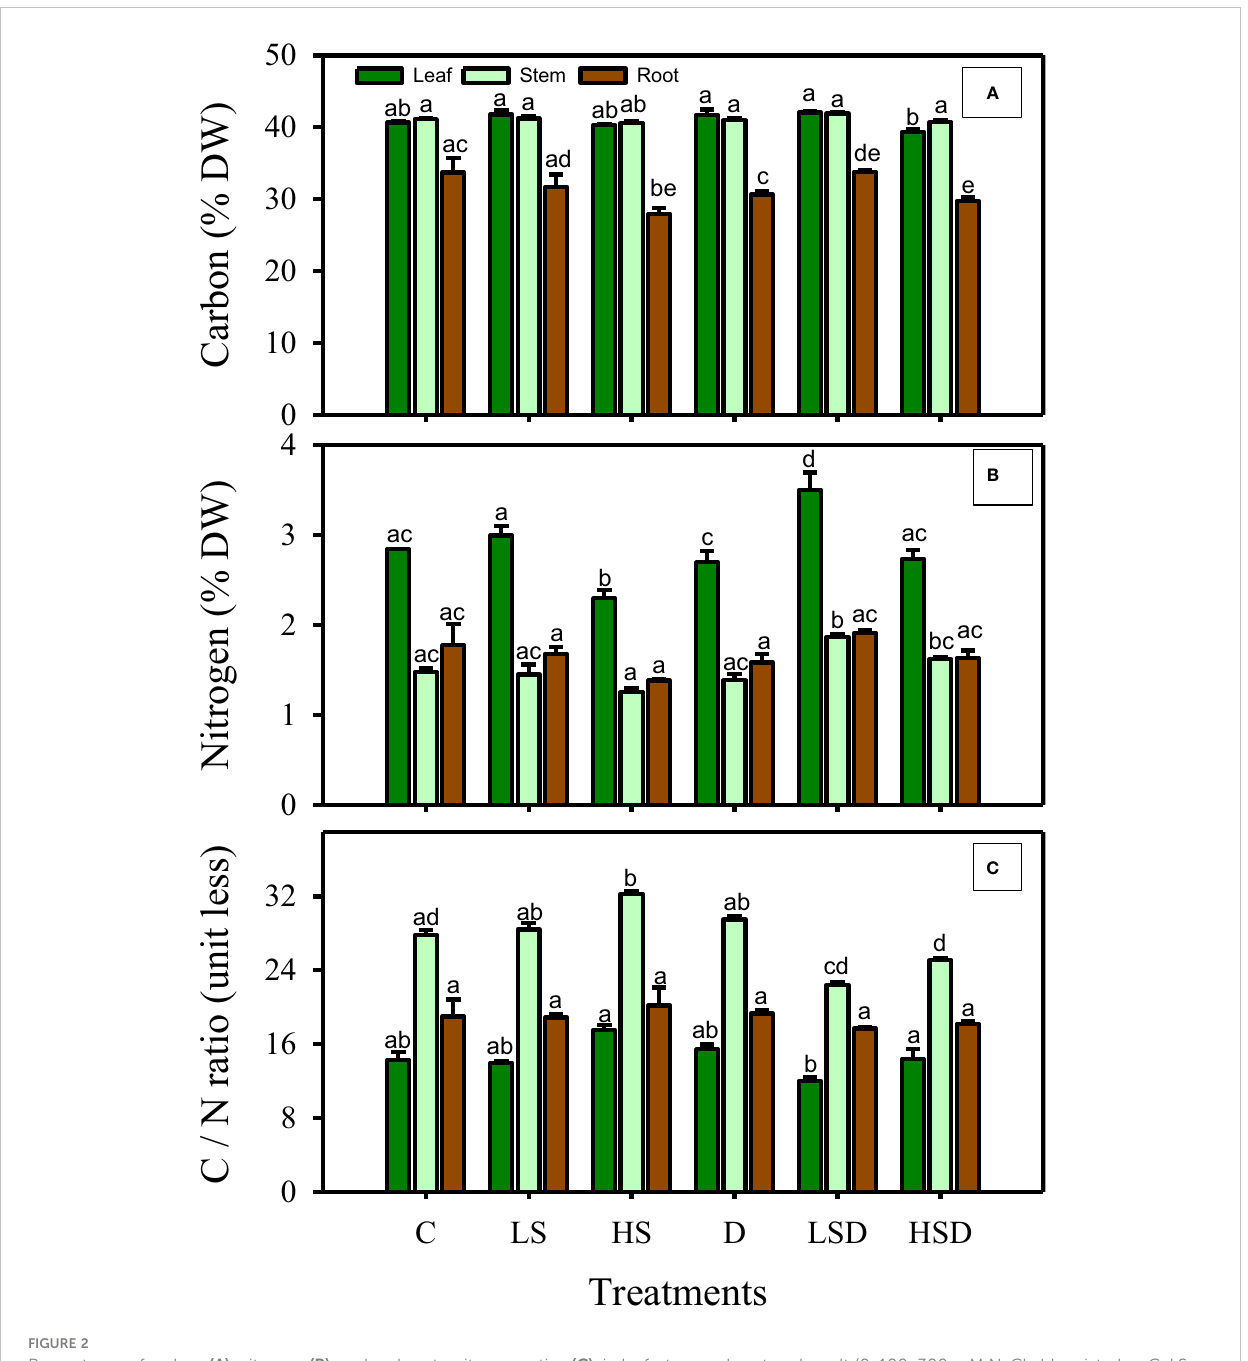
FIGURE 2 Percentages of carbon (A) , nitrogen (B) , and carbon to nitrogen ratios (C) , in leaf, stem and root under salt (0, 100, 300 mM NaCl abbreviated as C, LS and HS respectively), drought (D) and combination of both (abbreviated as LSD and HSD) treatments. The values represent the means and ± S.E (n = 3) where n is number of plants sampled from different pots. Different letters, after Bonferroni post hoc test, denote signi fi cant difference at P <